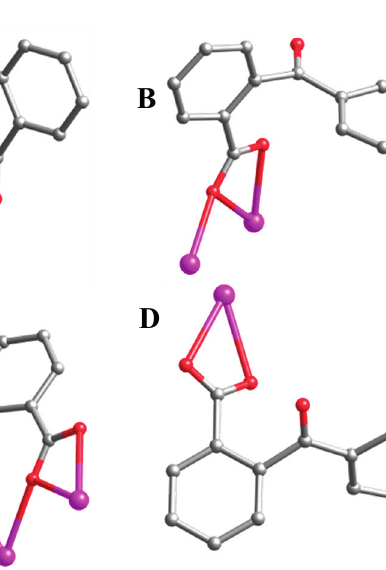
Figure 2. The coordination modes of 2,4-H 2 bpda ligand in complexes 1 – 3